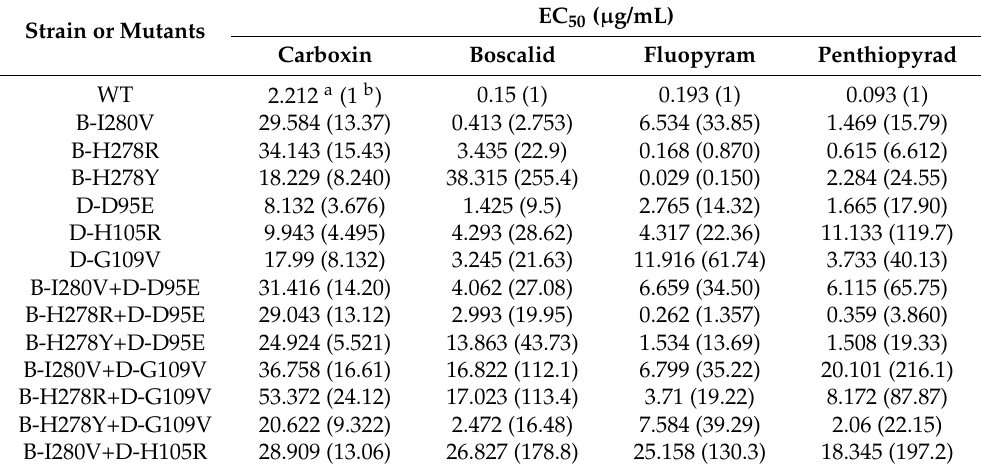
Table 1. Sensitivity of C. cassiicola to succinate dehydrogenase inhibitor (SDHI) fungicides. EC 50 ( µ g/mL) Strain or Mutants Carboxin Boscalid Fluopyram Penthiopyrad